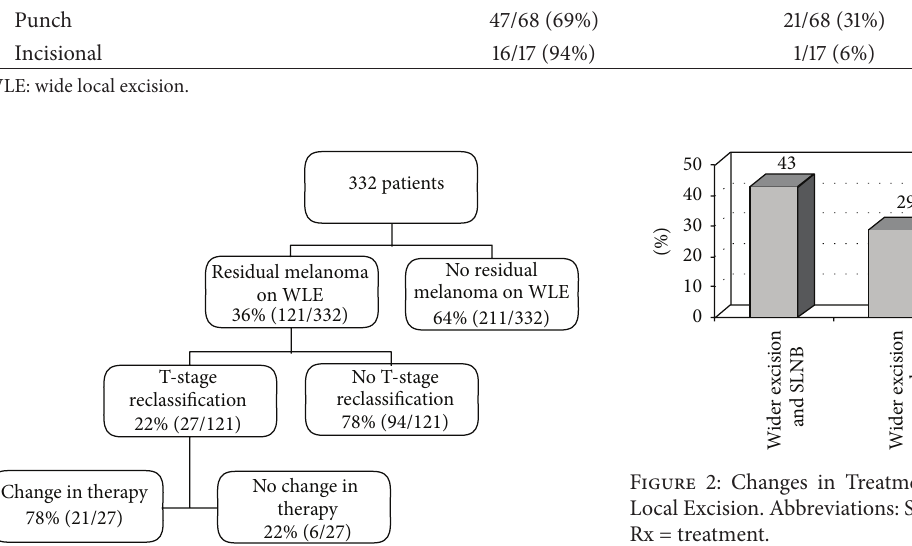
Figure 1: Effect of Finding Residual Melanoma on Wide Local Excision on T-Stage Change and Subsequent Change in Treatment.